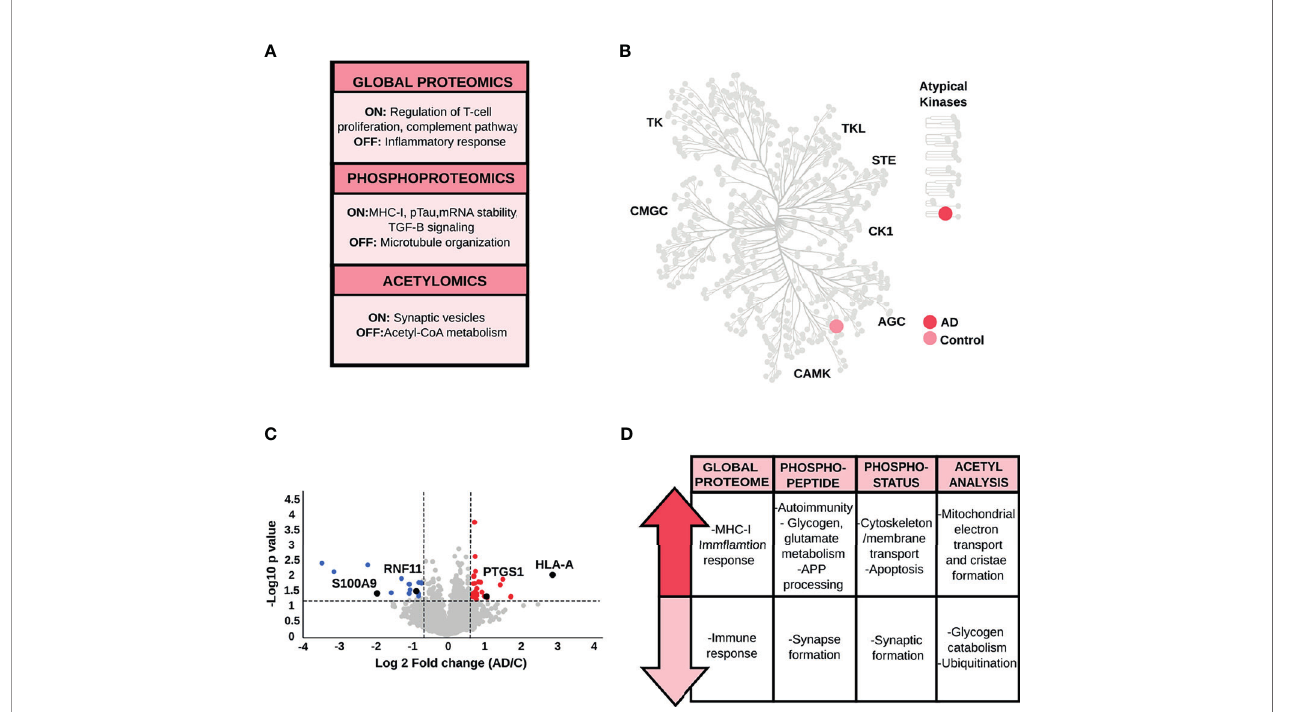
FIGURE 5 | (A) Biological processes derived from the qualitative analysis of the PRC. (B) Kinome map of the PRC based on the qualitative comparison of AD and control samples. (C) Volcano plot of the PRC global proteome data, as an example of the variation in the relative abundances of proteins between AD and control samples. (D) Key biological processes and pathways represented by proteins altered between control and AD samples in the